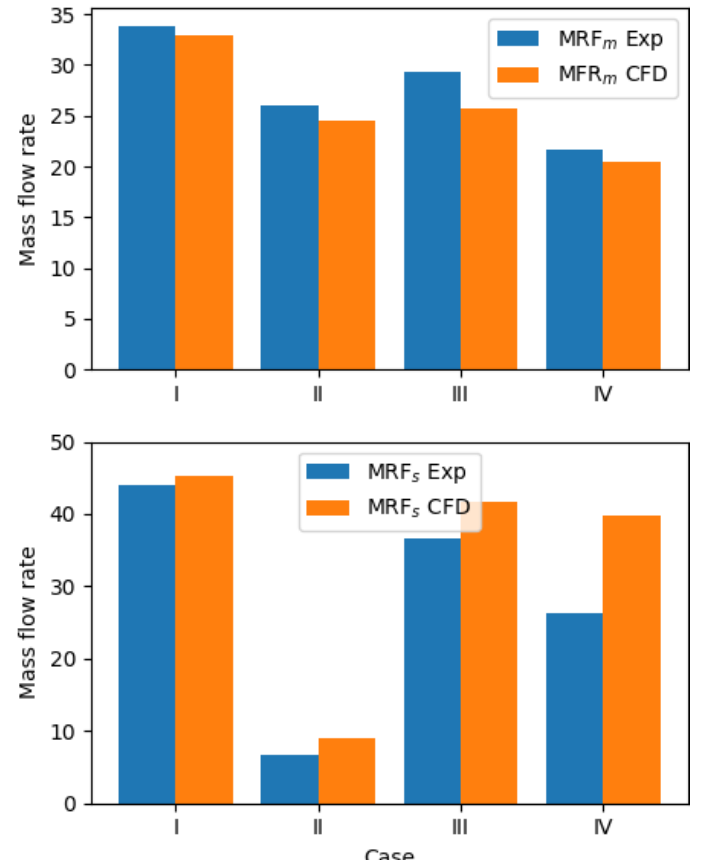
Figure 4. Comparison of experimental and numerical results in terms of motive ( upper ) and suction ( lower ) mass flow rate